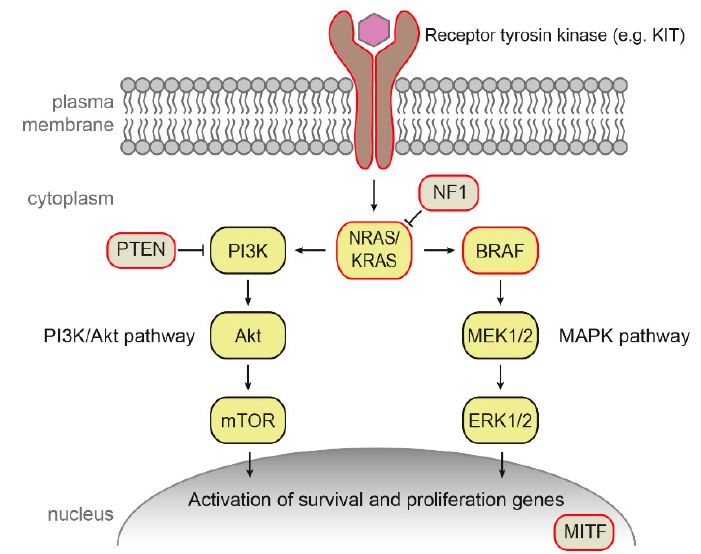
Figure 1. Mitogen-activated protein kinase (MAPK / MEK) and phosphatidylinositol 3-kinase (PI3K) / protein kinase B (Akt) pathways involved in sporadic melanoma. Mutations frequently present in melanoma tissue are highlighted in red.